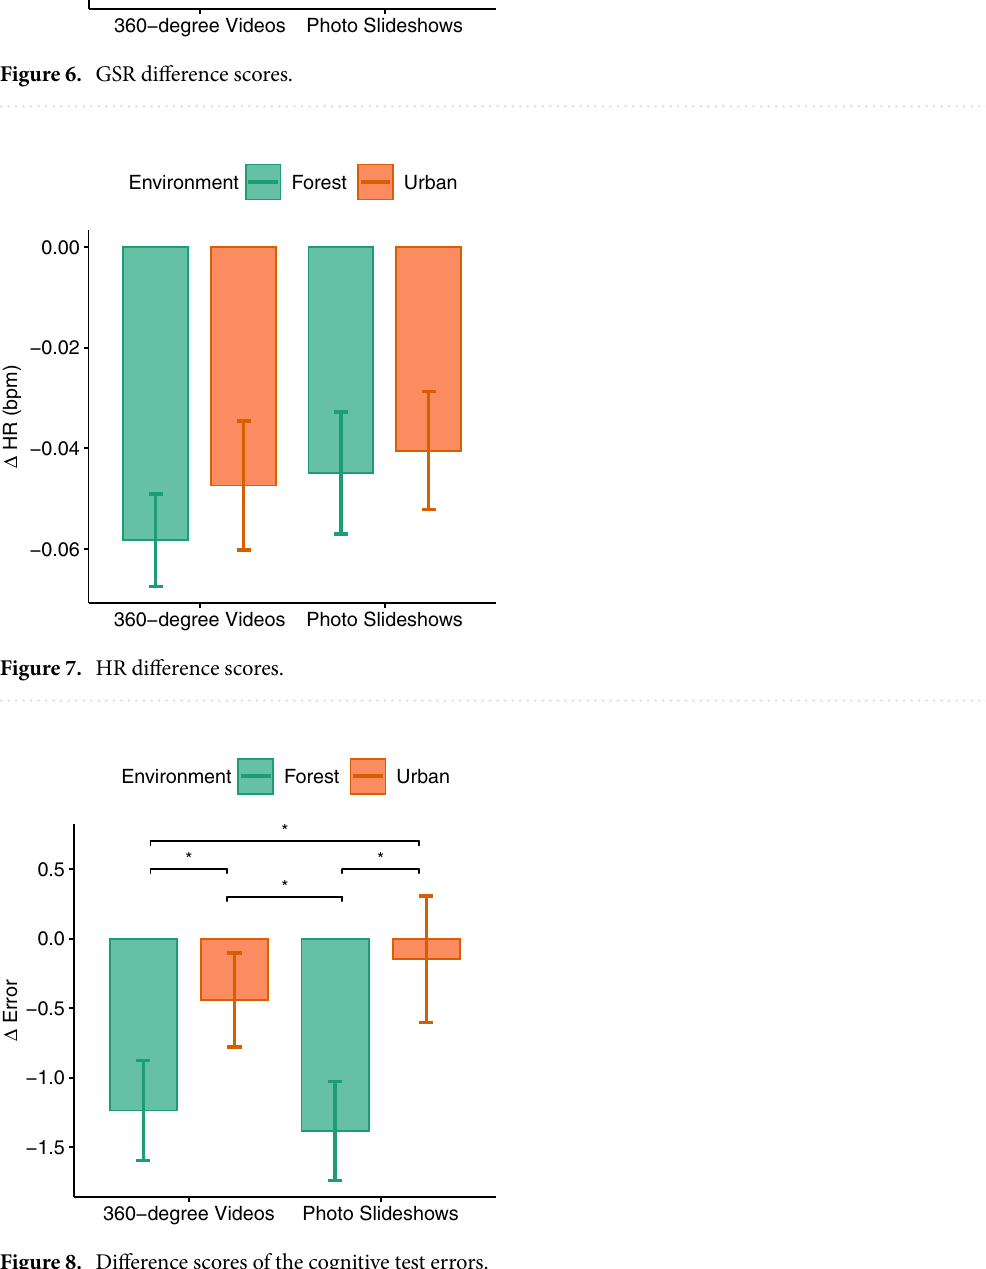
Figure 8. Difference scores of the cognitive test